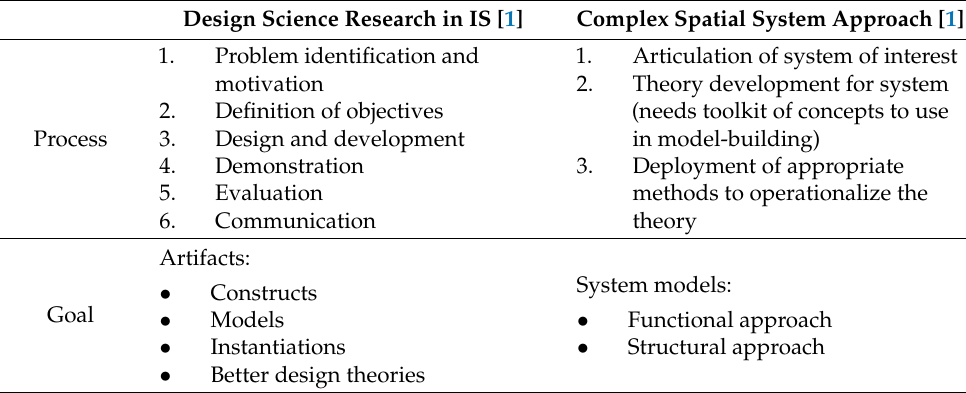
Table 1. Research methods used to define SP problem in